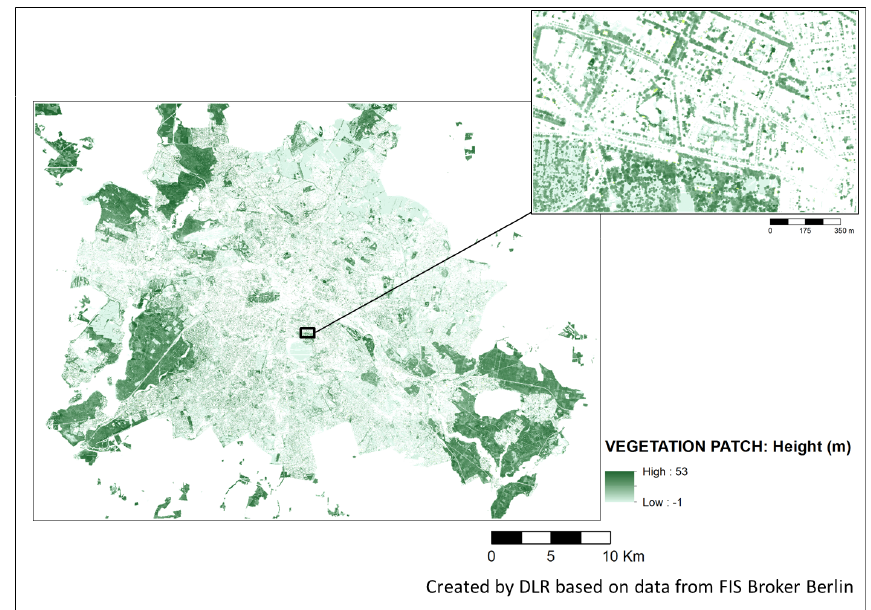
Figure 8. Height of vegetation patches in Berlin. Source: FIS Broker (dl-de/by-2-0: https://www.govdata.de/dl-de/by-2-0, last access: 26 Oc- tober 2020)